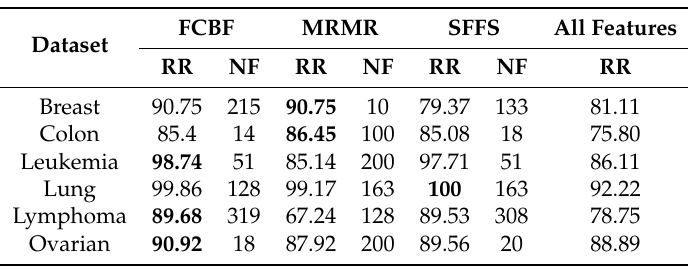
Table 7. Best results of heuristic search algorithms for feature selection with kNN